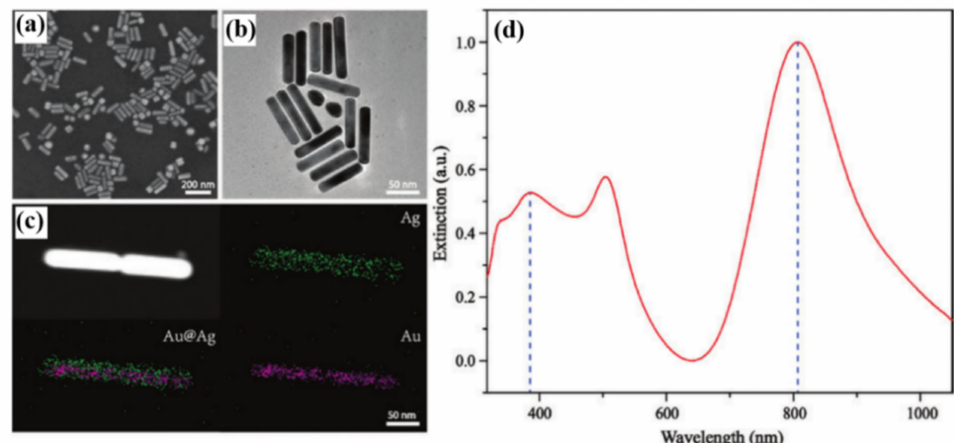
Figure 3. ( a , b ) Characterization image of Au@Ag NRs, respectively, by the scanning electron micro- scope (SEM) and transmission electron microscope (TEM). ( c ) Characterization results of different elemental compositions of Au@Ag NRs. ( d ) UV-Vis absorption spectra of experimentally synthesized